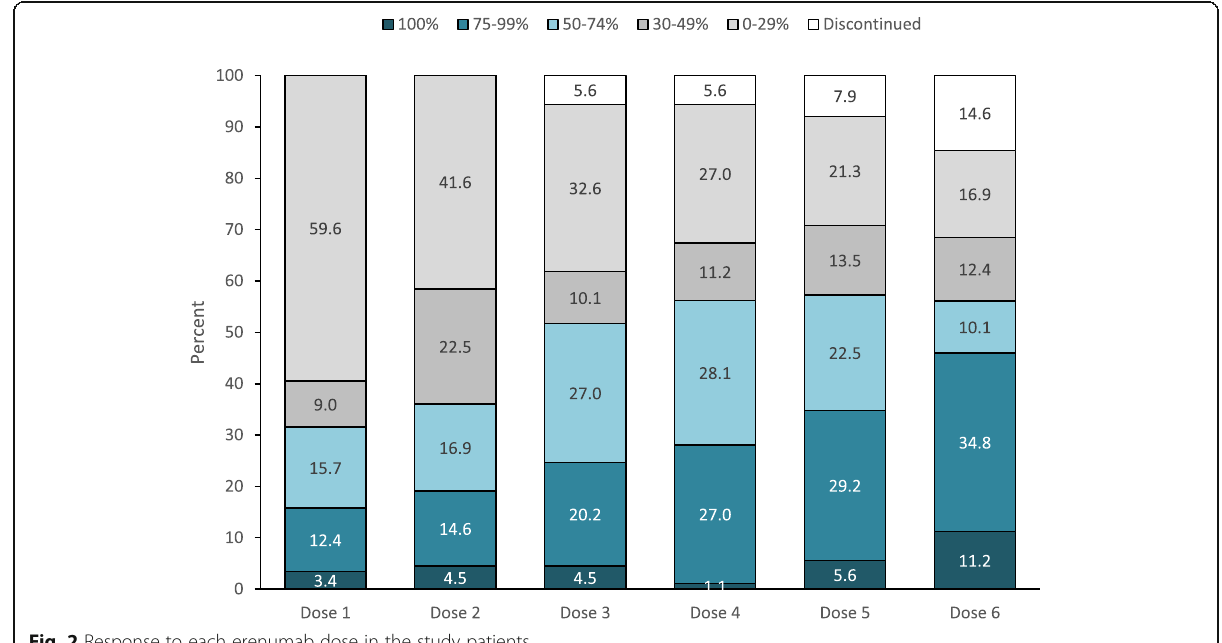
Fig. 2 Response to each erenumab dose in the study